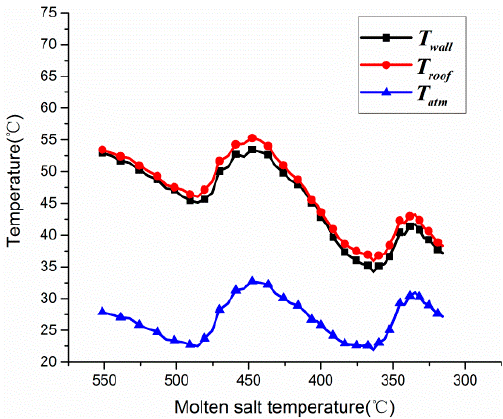
Figure 6. Variations in the temperature of the insulation surface and the ambient environment.